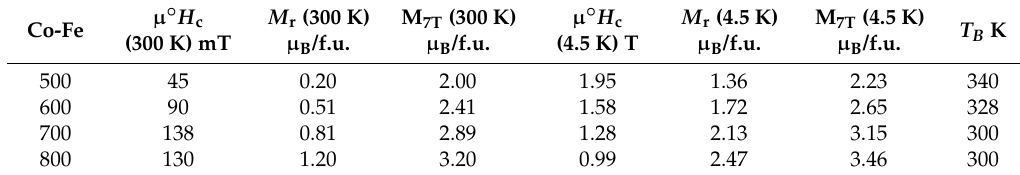
Figure 10. Magnetization curves of CoFe 2 O 4 recorded at 300 K ( a ) and 4.5 K ( b ). A blow-up of two hysteresis curves (Co-Fe-500 and Co-Fe-800) is shown in the inset of panel ( a ). Table 2. Coercivity filed µ ◦ H c , remanent magnetization M r , magnetic moment at the maximum field M 7T obtained from the magnetization curves measured at 300 K and 4.5 K, and the blocking temperature T B determined as a furcation point between field cooled and zero-field cooled (FC and ZFC) curves of magnetic susceptibility.